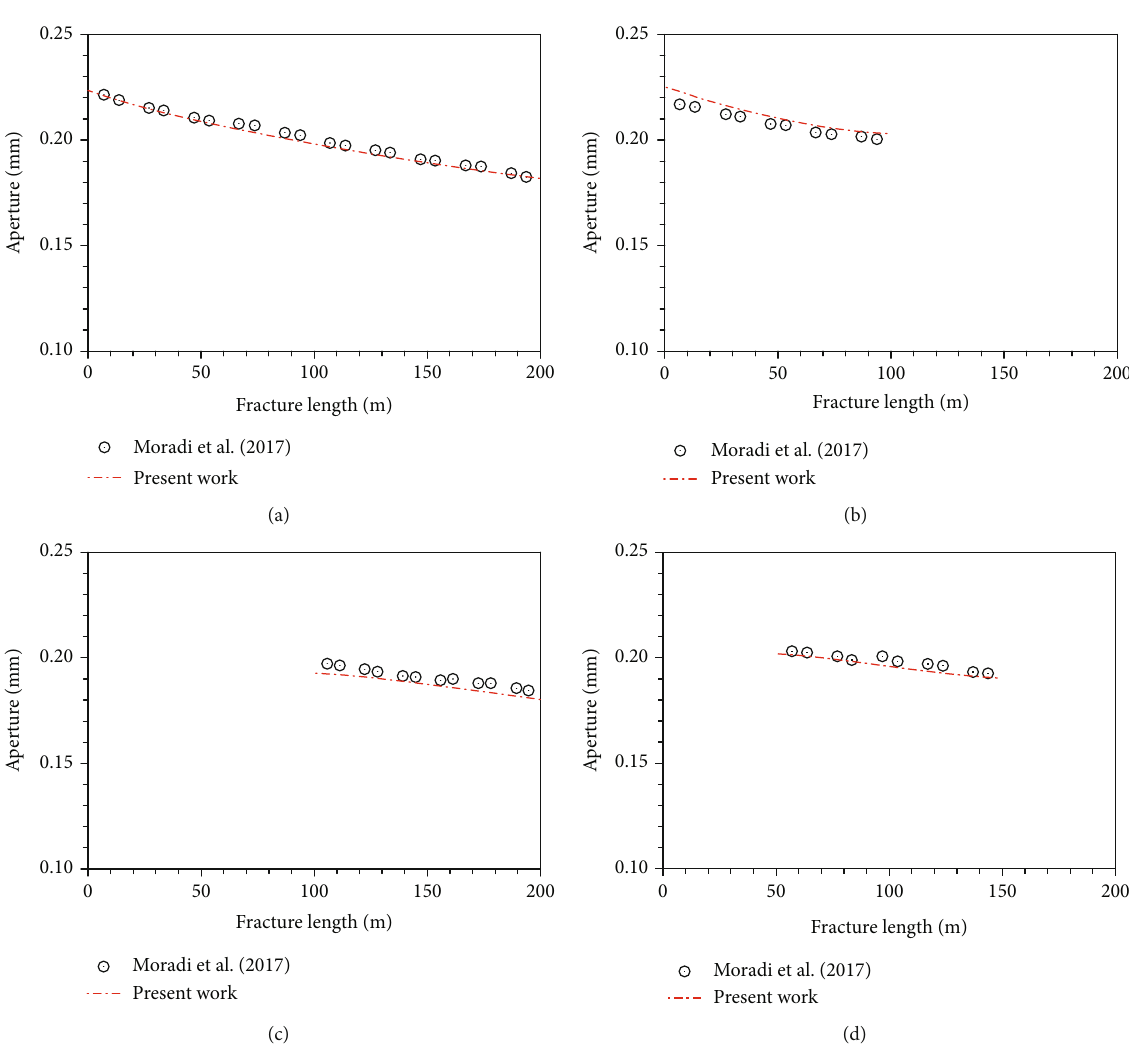
Figure 6: Comparison of fracture apertures at di ff erent